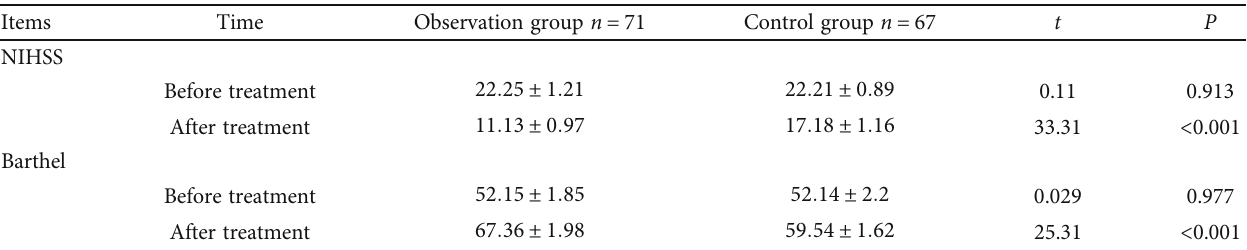
Table 3: Comparison of neurological de fi cit scores and activities of daily living between two groups before and after